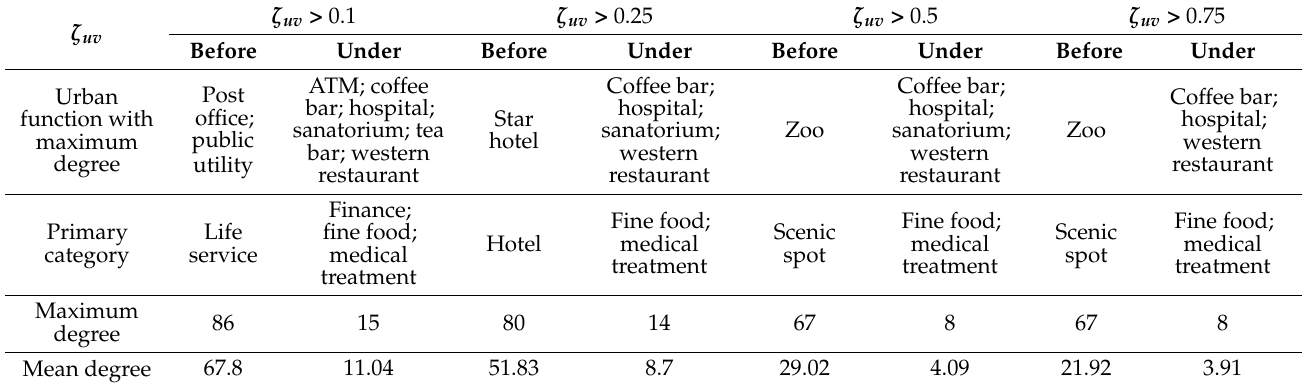
Table 3. Urban functions with positive interdependencies before and under the lockdown of COVID-19.